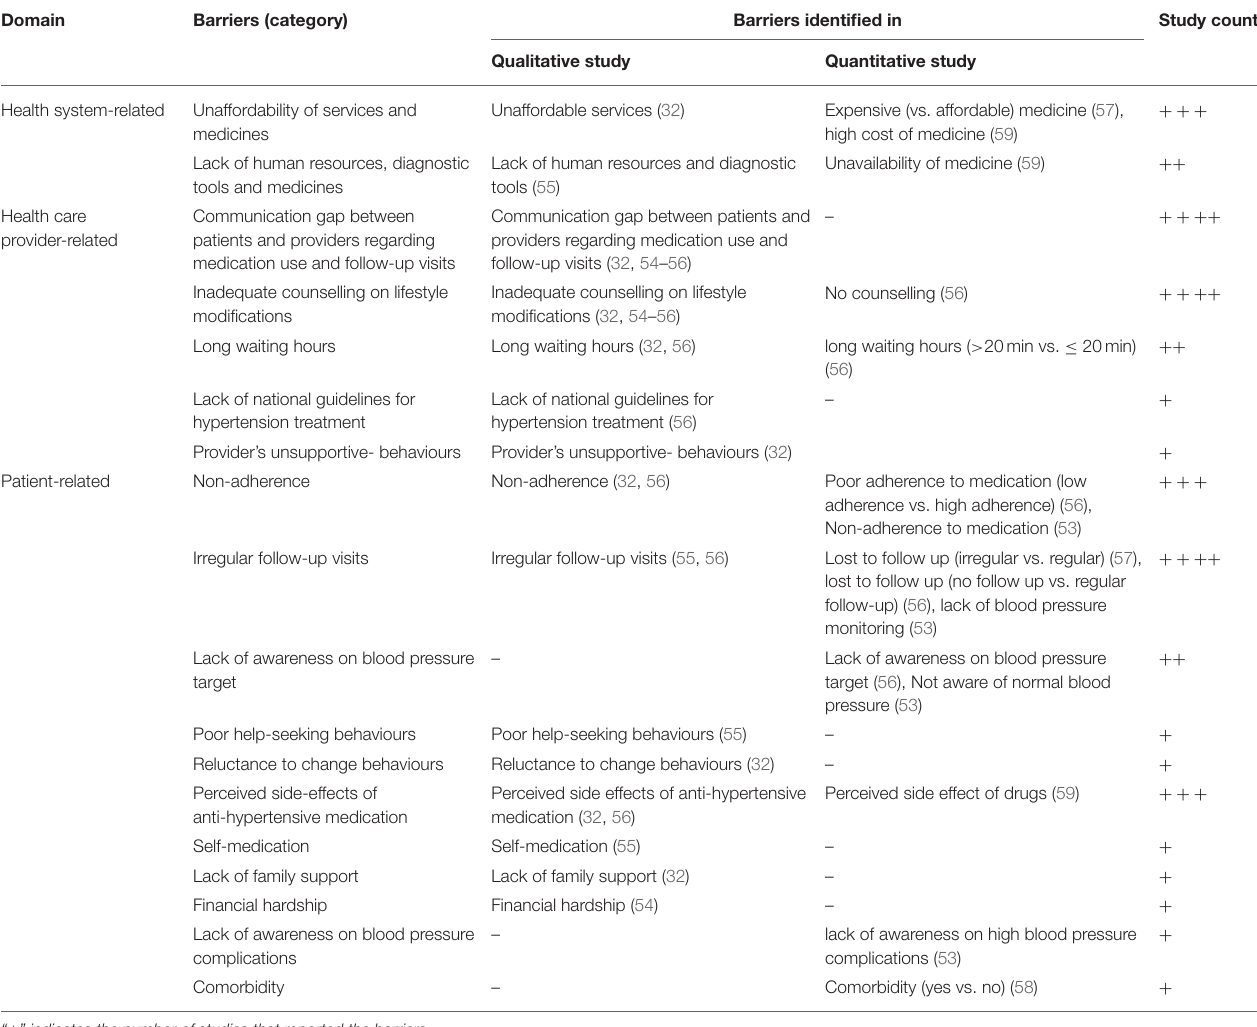
TABLE 1 | Barriers to hypertension treatment and control in Nepal.